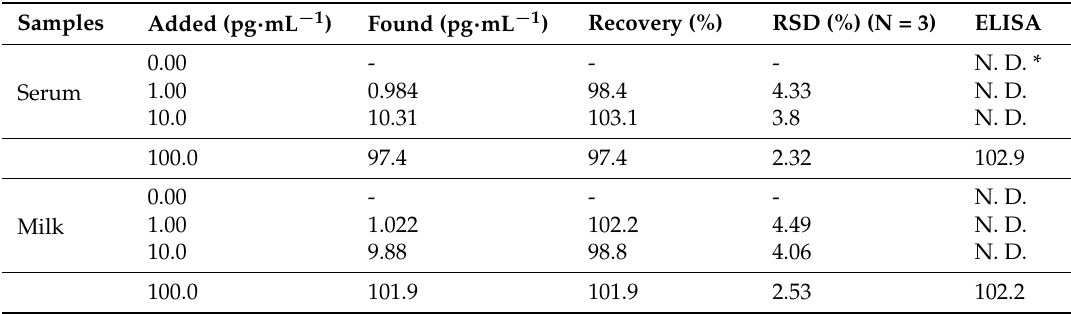
Table 2. The obtained immunosensor performance results in real